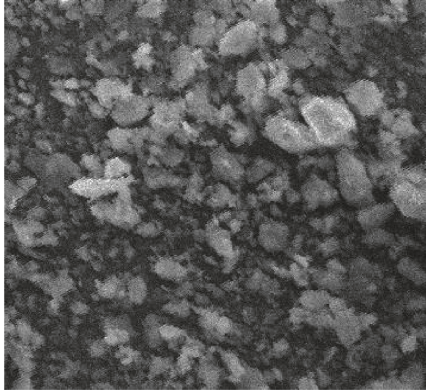
Figure 5: SEM image of SP-ZnONPs.